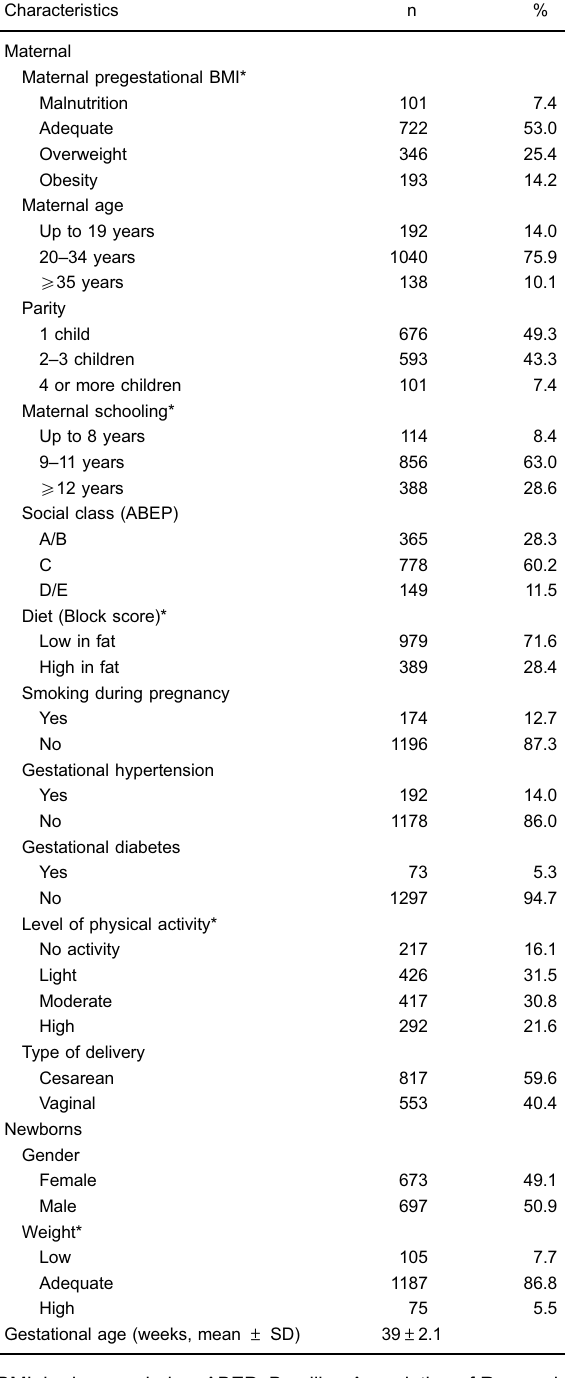
Figure 2. Flowchart of the study population.